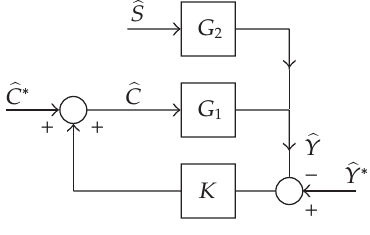
Figure 4.1 The closed loop